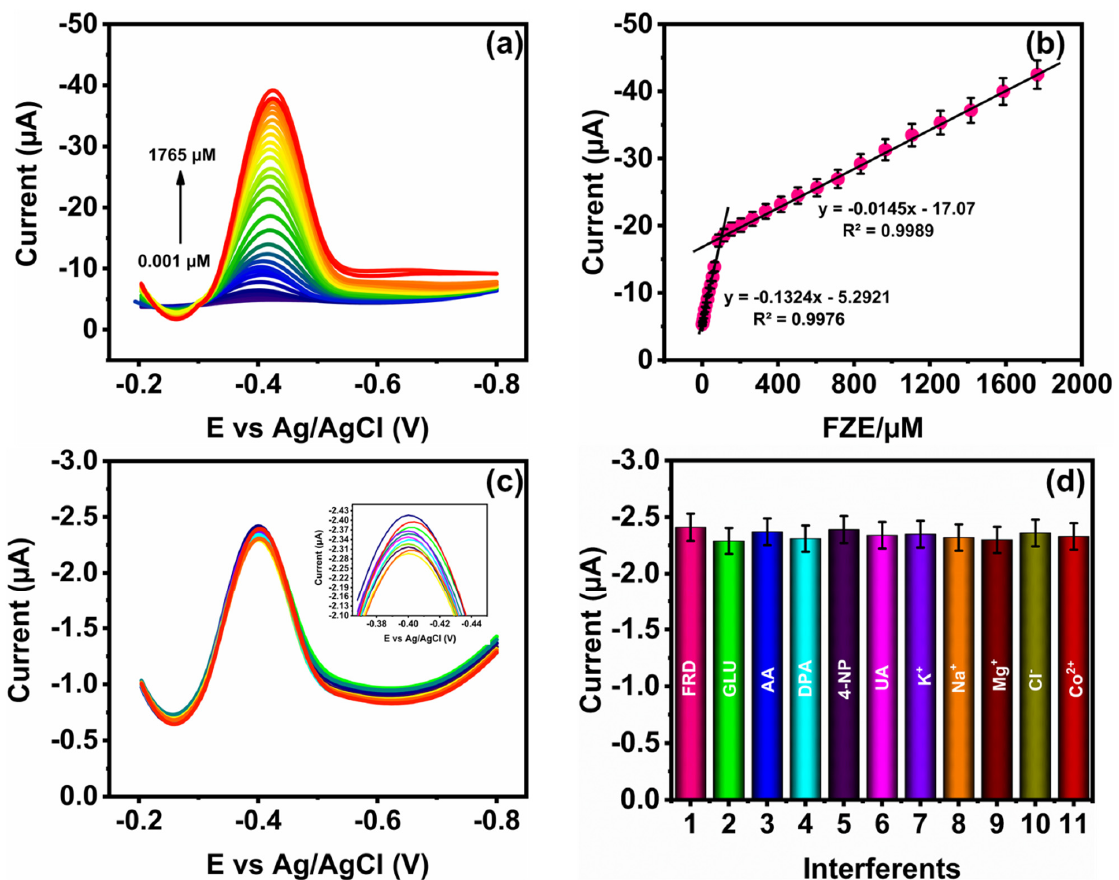
Figure 9. ( a ) DPV response of NMO/GCE with the sequential addition of FZE (pH-7), ( b ) the linear plot for concentrations of FZE vs. reduction current, ( c ) DPV current response of NMO/GCE to various interfering molecules for FZE detection (inset: zoom view of the interference response), and ( d ) the bar diagram of the reduction current response vs. interfering reagents. Table 1. The obtained electrochemical parameters of NMO/GCE for the electrochemical detection of FZE were compared with other literature.